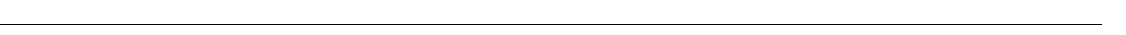
Fig. 1 Structural characterizations of PKD2L1. a General topology of PKD2L1. PKD2 has a similar topology with a longer N-terminus and no